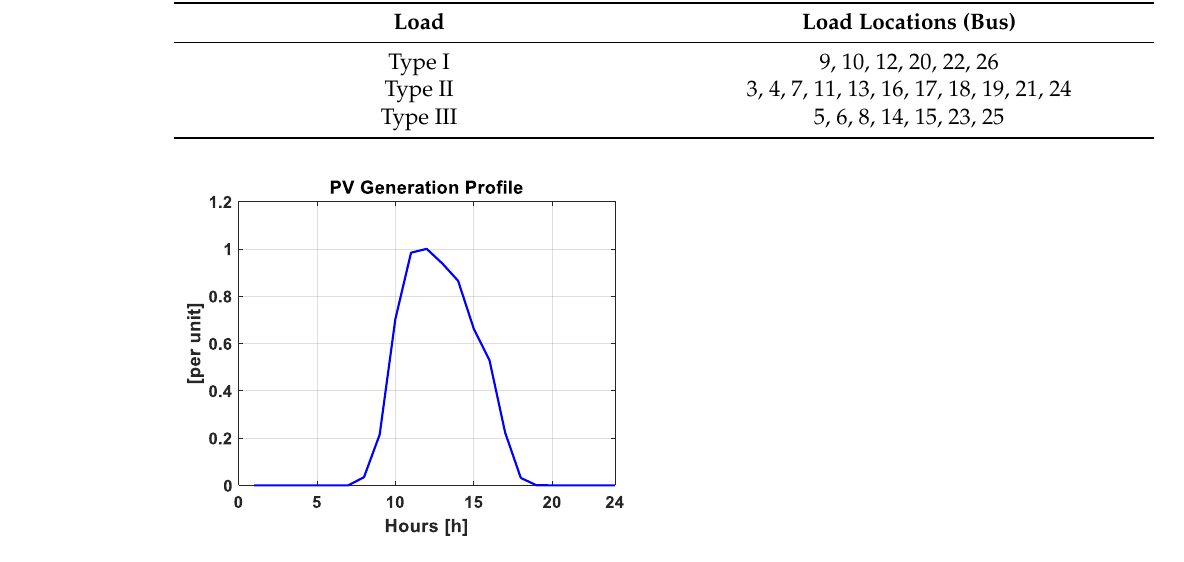
Figure 8. Photovoltaic (PV) generation profile.